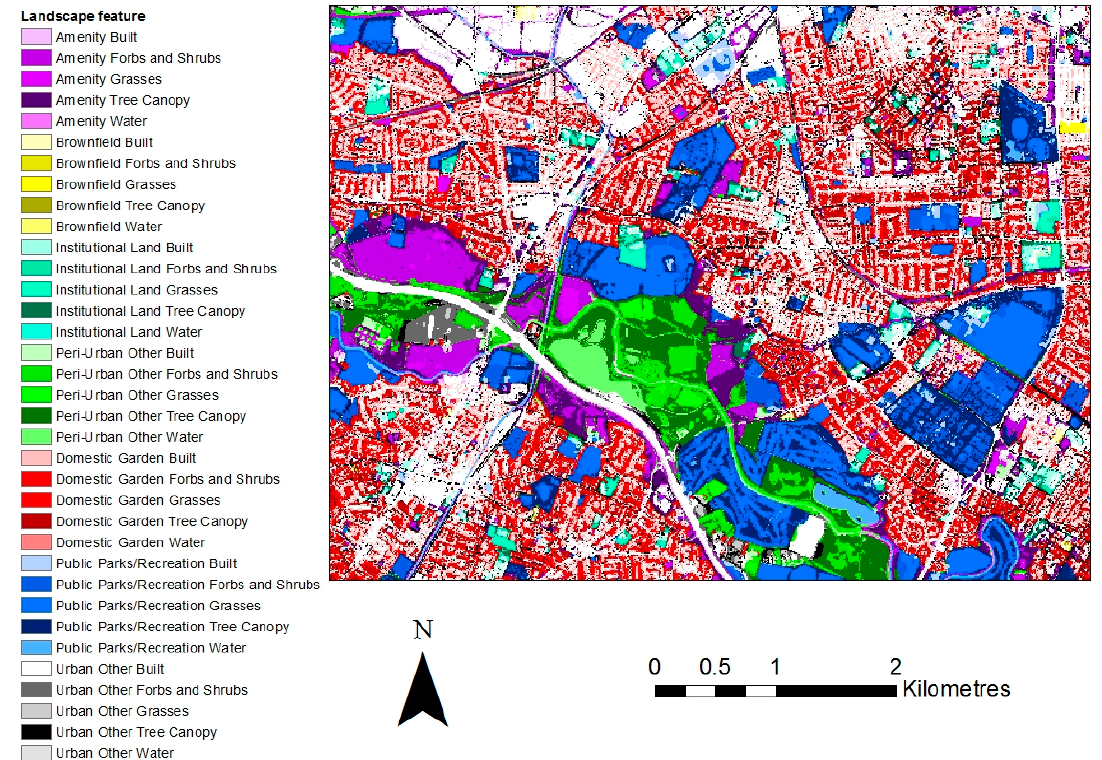
Figure 8. Final classification of the ILM dataset into 35 classes of landscape features (contains Ordnance Survey, 2017; European Space Agency, 2016 and City of Trees 2011 data).